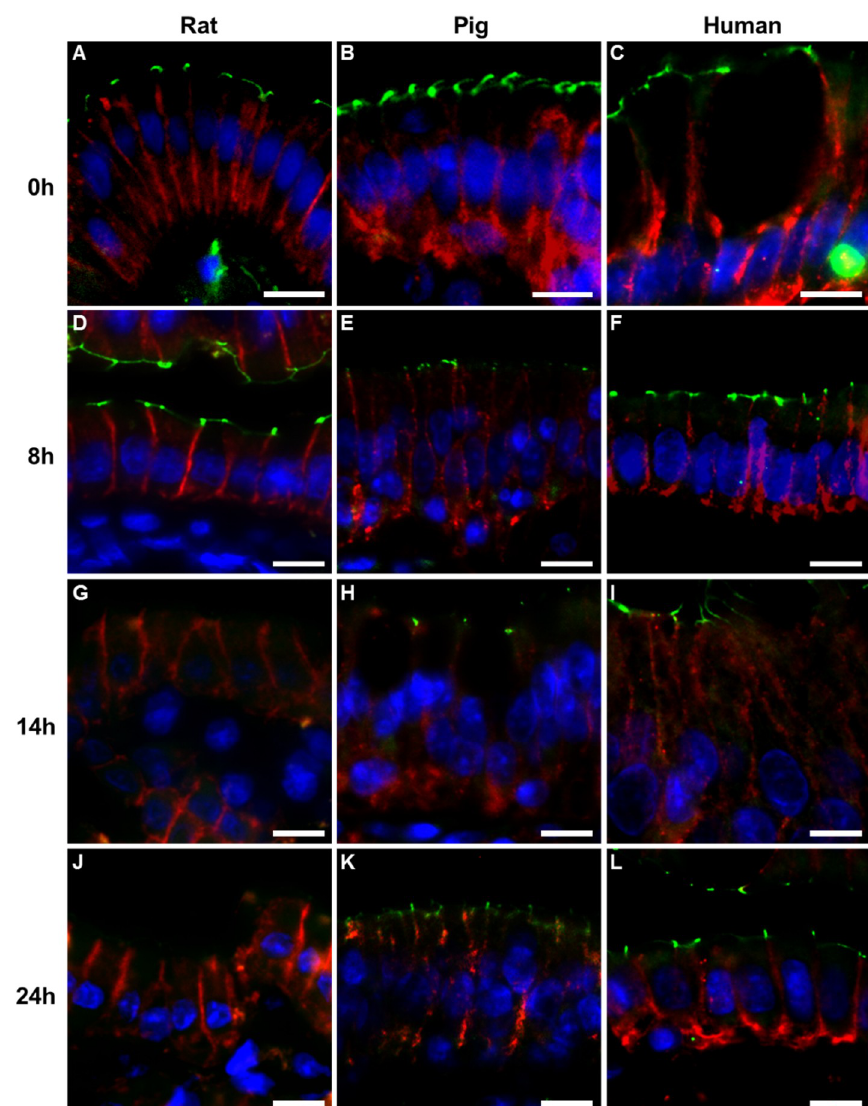
Figure 3. Immunofluorescent staining for zonula occludens (ZO)-1 (green) and claudin-3 (red) after various periods of cold storage (CS); strong immunofluorescent signal for both proteins after 8 h CS in rat ( A ), pig ( B ), and human intestine ( C ); after 14 h, ZO-1 signal was lost in rat ( D ) but not pig ( E ) or human ( F ) intestinal mucosa; after 24 h ( J – L ) of CS, ZO-1 staining was absent and claudin-3 revealed diffuse membrane staining and cytoplasmic staining in rat intestines ( G ), while in pig ( H ) and human ( I ) intestines, ZO-1 signal was maintained and claudin-3 stained more diffuse, stronger on the subjunctional basolateral membrane, together with some cytoplasmic staining. Nuclei were stained blue using 4 (cid:48) ,6-diamidino-2-phenylindole (DAPI). Images were acquired from areas where enterocytes still remained attached to the lamina propria and as close to the villus tip as possible. Original magnification × 400, scale bar, 10 µ